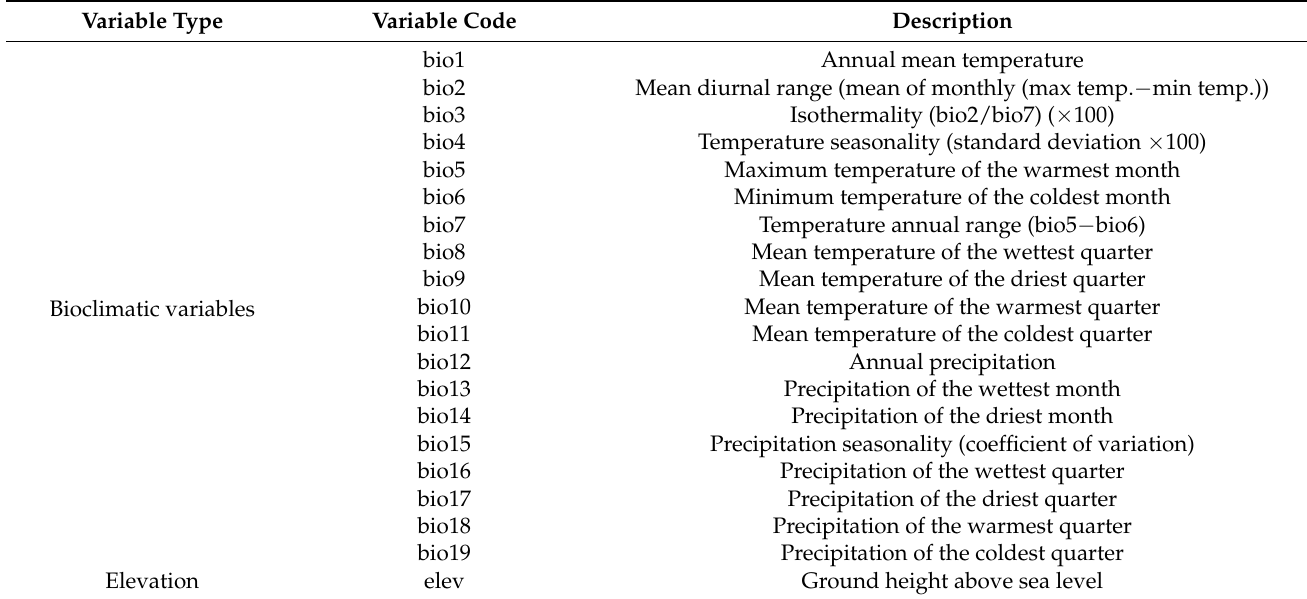
Table 1. Environmental variables considered in the MaxEnt models of MEAM1 and MED cryptic species of the Bemisia tabaci species complex in